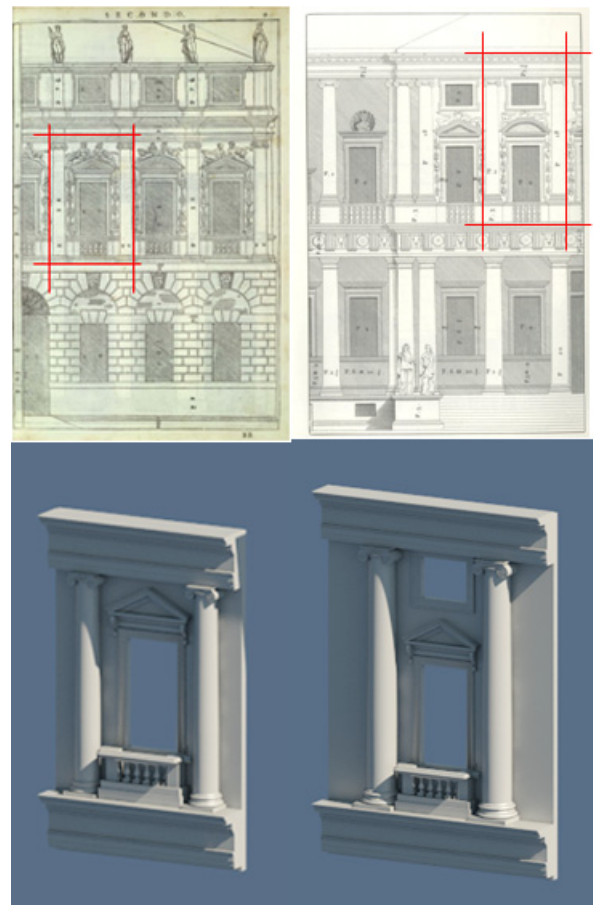
Figure 6. The basic unit of repetition on